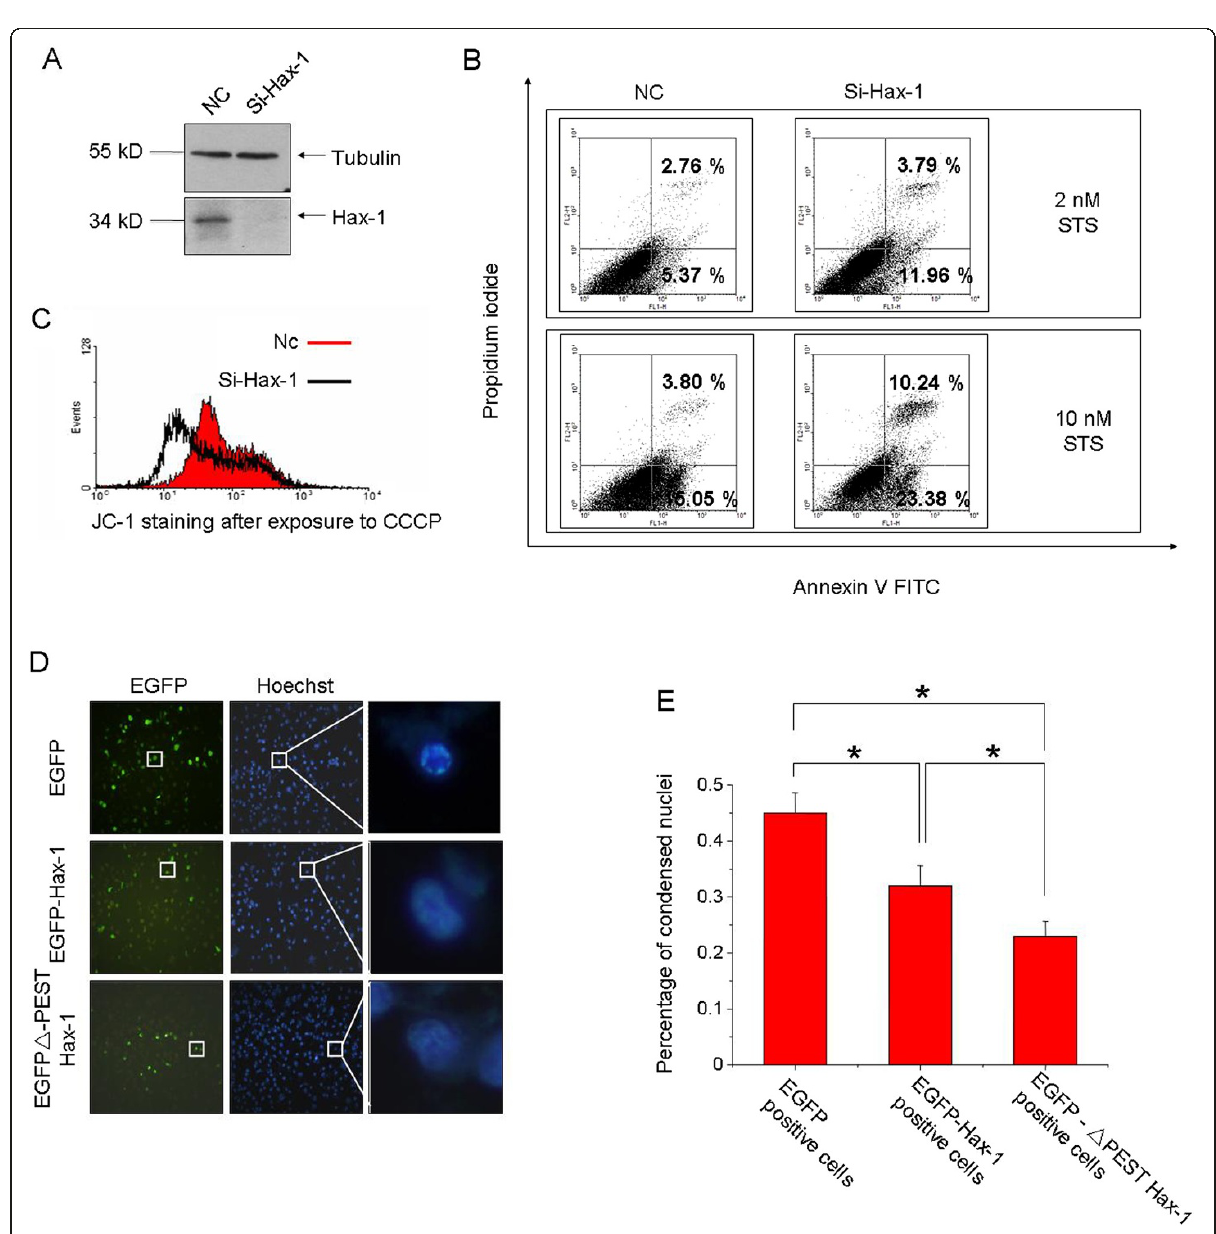
Figure 4 Δ PEST Hax-1 strongly attenuates apoptosis. A . Knockdown efficiency of Hax-1 siRNA used in this study. B . H1299 cells were transfected with negative control (NC) or siRNA against Hax-1 and then treated with different doses of STS (2 – 10 nM) for 2 hours. Cells were double stained with annexin V-FITC and PI followed by FACS analyses. C . H1299 cells were transfected with NC or siRNA against Hax-1 and then treated with CCCP (10 μ M) for 30 minutes. After CCCP treatment, cells were stained with a JC-1 mitochondrial membrane potential detection kit. D . H1299 cells were transfected with EGFP or EGFP-Hax-1 or EGFP- Δ PEST Hax-1. Forty-eight hours later, cells were treated with STS (20 nM) for 12 hours and stained with Hoechst 33342. E . Quantitative analysis of condensed nuclei from D with three independent experiments was performed; random field of 250 cells were counted. (means±S.E.M., *p < 0.05, one-way